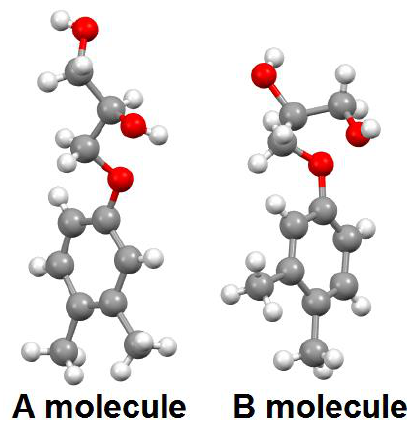
Figure 10. Probable geometry of two symmetrically-independent R -molecules in β - rac - 1 crystals.